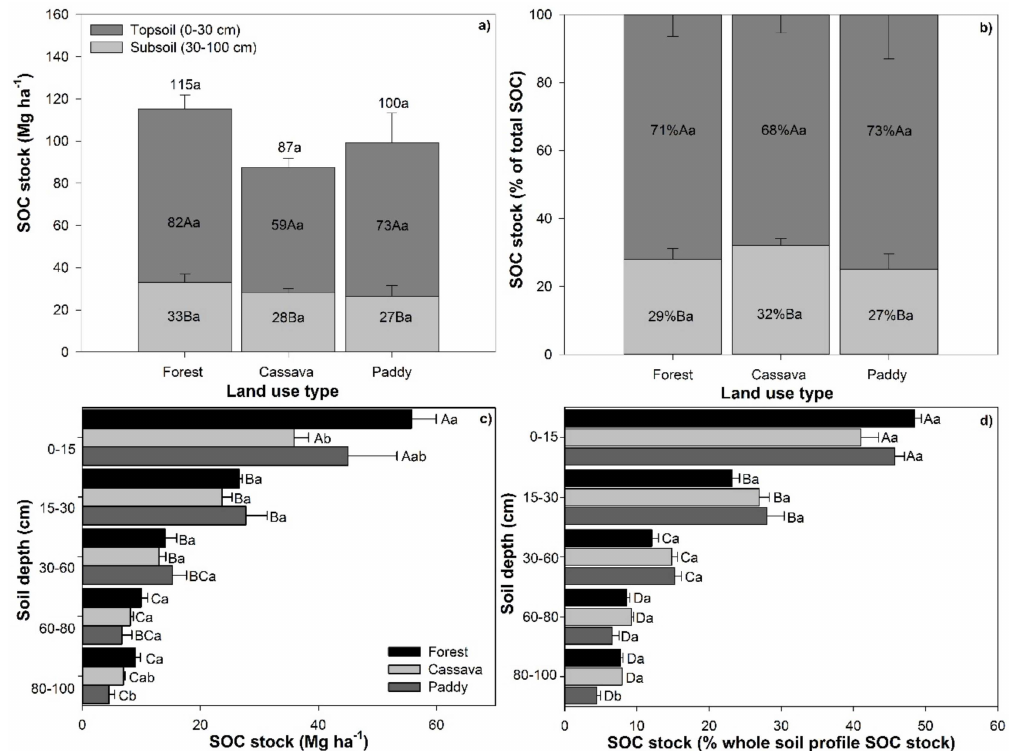
Figure 3. Land use changes a ff ecting soil organic carbon (SOC) stocks in soil profile: ( a ) whole SOC stocks (Mg ha − 1 ), ( b ) whole SOC stocks (percentage of total SOC), ( c ) distribution of SOC stocks (Mg ha − 1 ), and ( d ) distribution of SOC stocks (percentage of total SOC). Uppercase letters accompanying bar graphs denote comparisons of SOC stocks among di ff erent soil depths in the same land use type, and lowercase letters denote comparisons of those of di ff erent land uses at each soil depth. Similar letters indicate no significant di ff erences ( p > 0.05), as analyzed by the least significant di ff erence (LSD) method. Error bars represent standard error of the